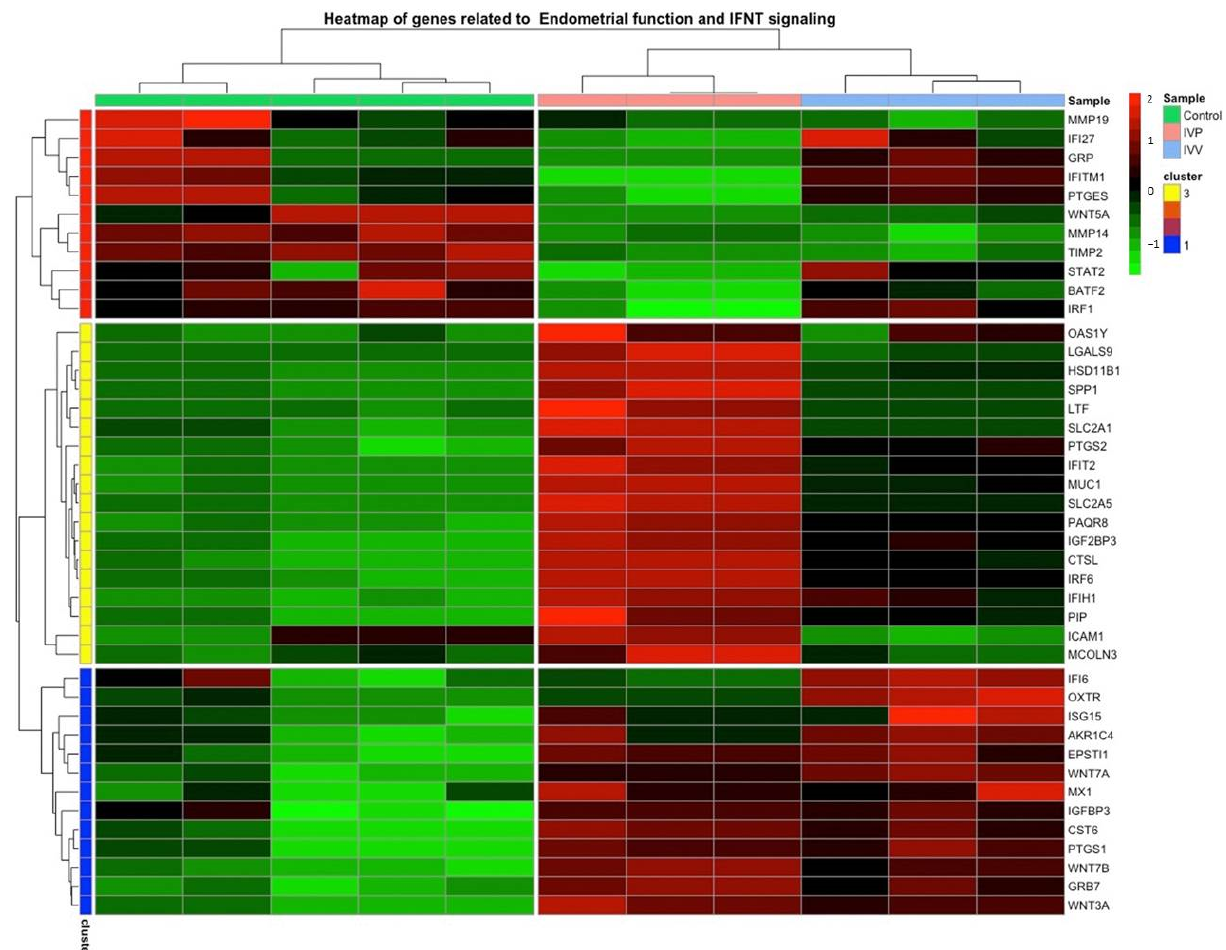
Figure 5. Heat map profile of differentially expressed genes related to IFNT signaling and endometrial function. Three clusters were defined: Cluster 1 includes genes associated with sex steroid signaling and interferon signaling; Cluster 2 includes solute and water transport secretory activity, proliferation activity, and interferon signaling; Cluster 3 includes extracellular matrix remodeling, proliferation activity and interferon signaling.